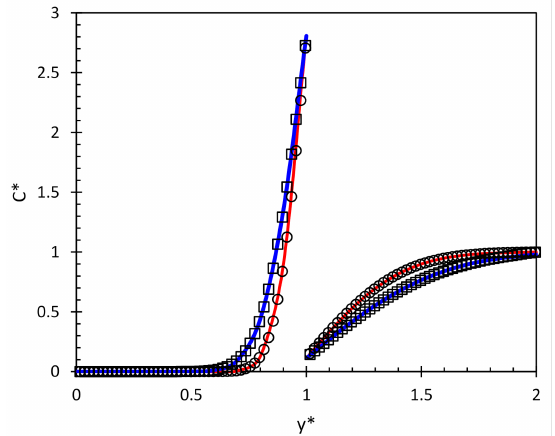
Figure A4. Dimensionless flux. The blue and red lines are at dimensionless time of 0.005 and 0.01, and the dots are numerical values.